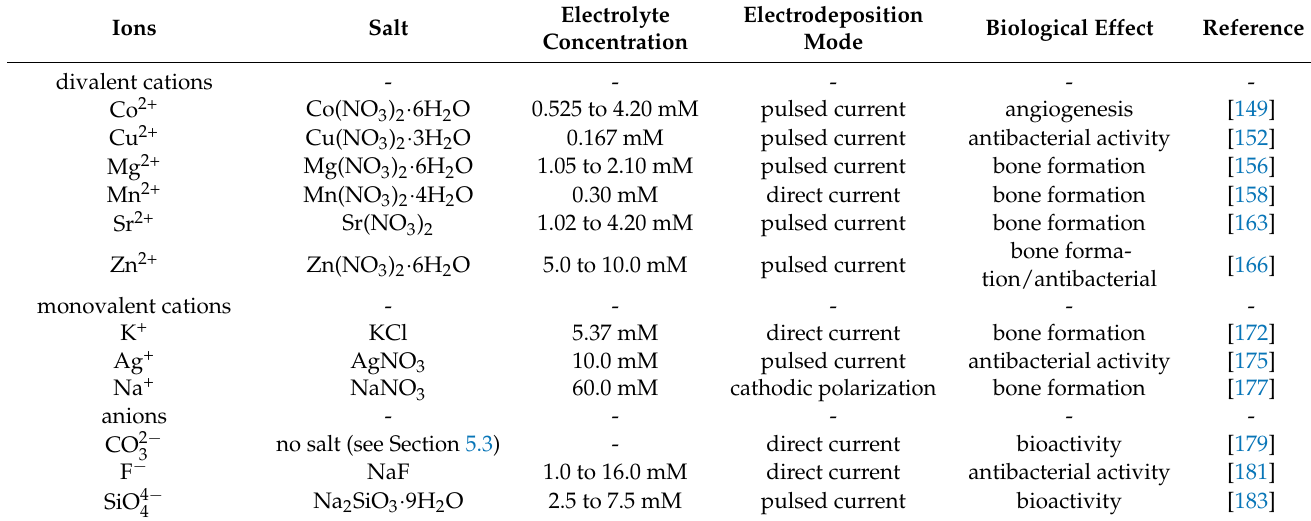
Table 2. Main ions used to substitute electrodeposited calcium phosphate